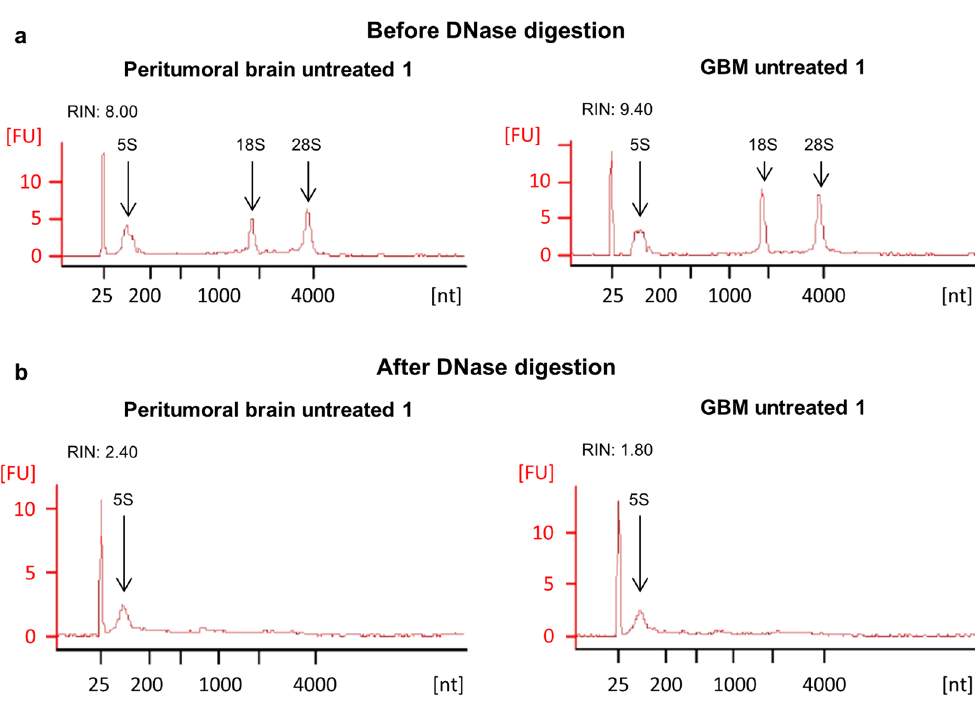
Figure 2. RNA quality of cultivated tissue slices. RNA quality was determined by a Bioanalyzer 2100 using the RNA 6000 Nano-Kit (Agilent Technologies) and revealed good quality before the DNase digestion was performed ( a ). After the DNase digestion, the RNA quality was strongly reduced ( b ). The left graphs show untreated peritumoral brain tissue, the right graphs the corresponding GBM